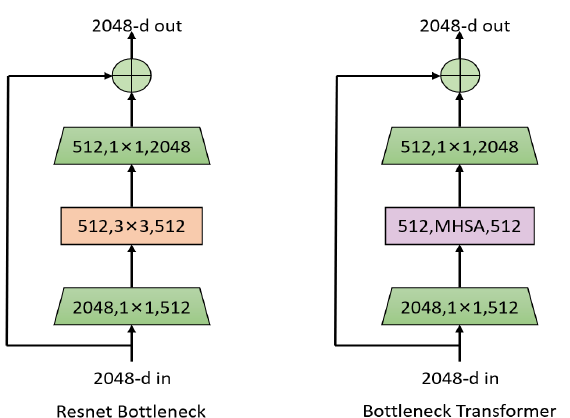
Figure 2. Comparison of Resnet Bottleneck and Bottleneck Transformer.